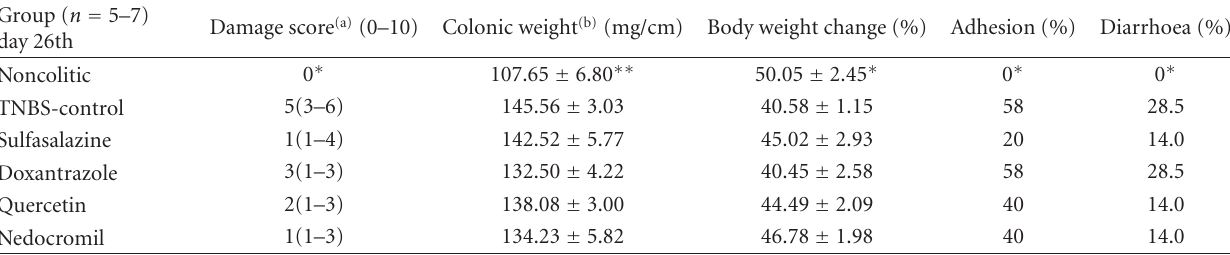
Table 4: E ff ects of sulfasalazine, doxantrazole, quercetine, and nedocromil treatment on damage score, changes in colonic weight, body weight, and incidence of diarrhea and adhesions in reactivated TNBS